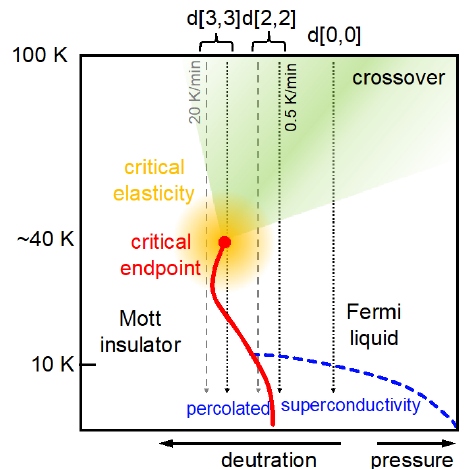
Figure 1. A schematic view of the two-dimensional (2D) dimer-Mott phase diagram for the κ -(BEDT-TTF) 2 X system. The positions of the d[0,0], d[2,2], and d[3,3] compounds in a slowly cooled case are shown by the dashed arrows. The possible positions for the rapidly cooled cases (20 K min − 1 ) for the latter two compounds are also shown by the gray dashed arrows. The position of the Mott boundary and that of the critical endpoint are shown in the red color.